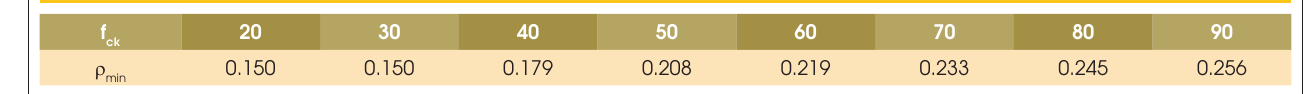
(A /Ac) (%) as a function of f min s,min